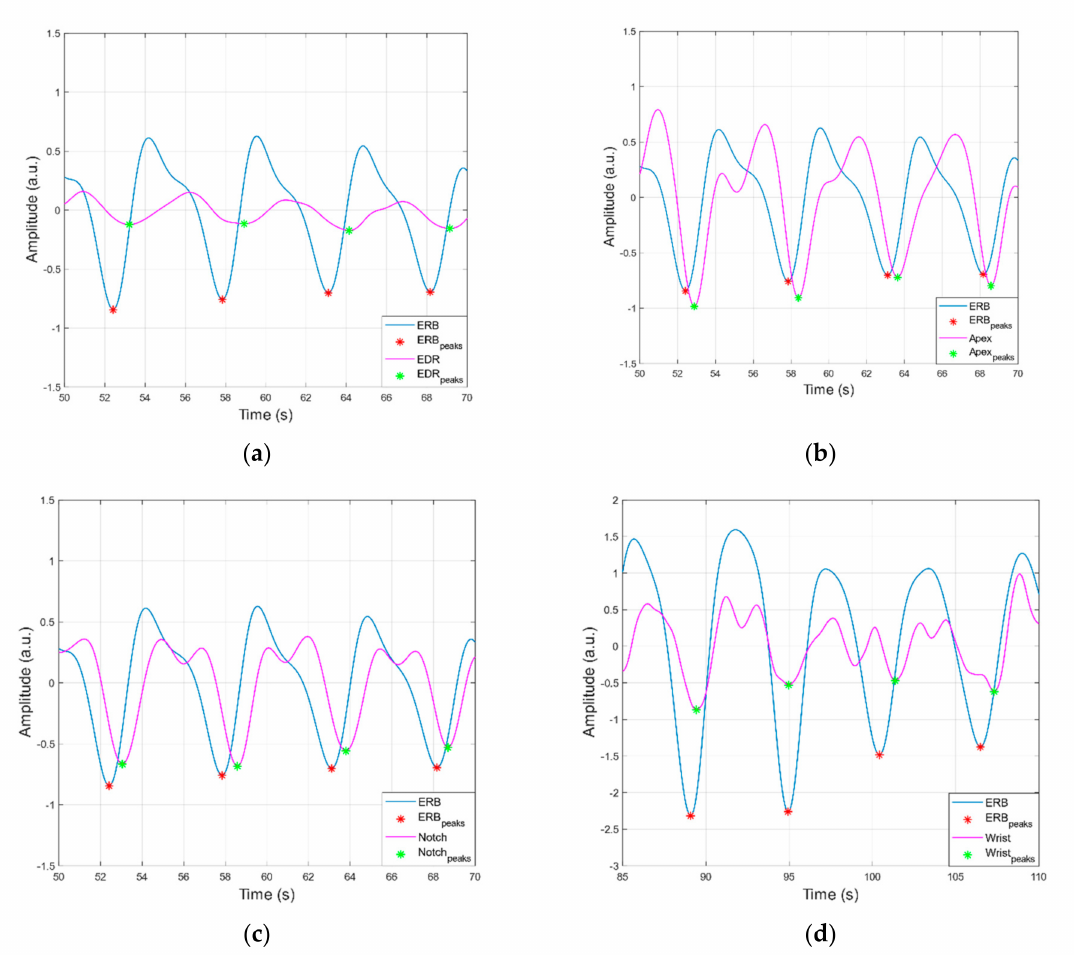
Figure 10. Examples of peaks detection in ERB signal versus: ( a ) EDR and ( b – d ) respiration monitoring signals acquired via the proposed sensor from heart apex, suprasternal notch and wrist, respectively.